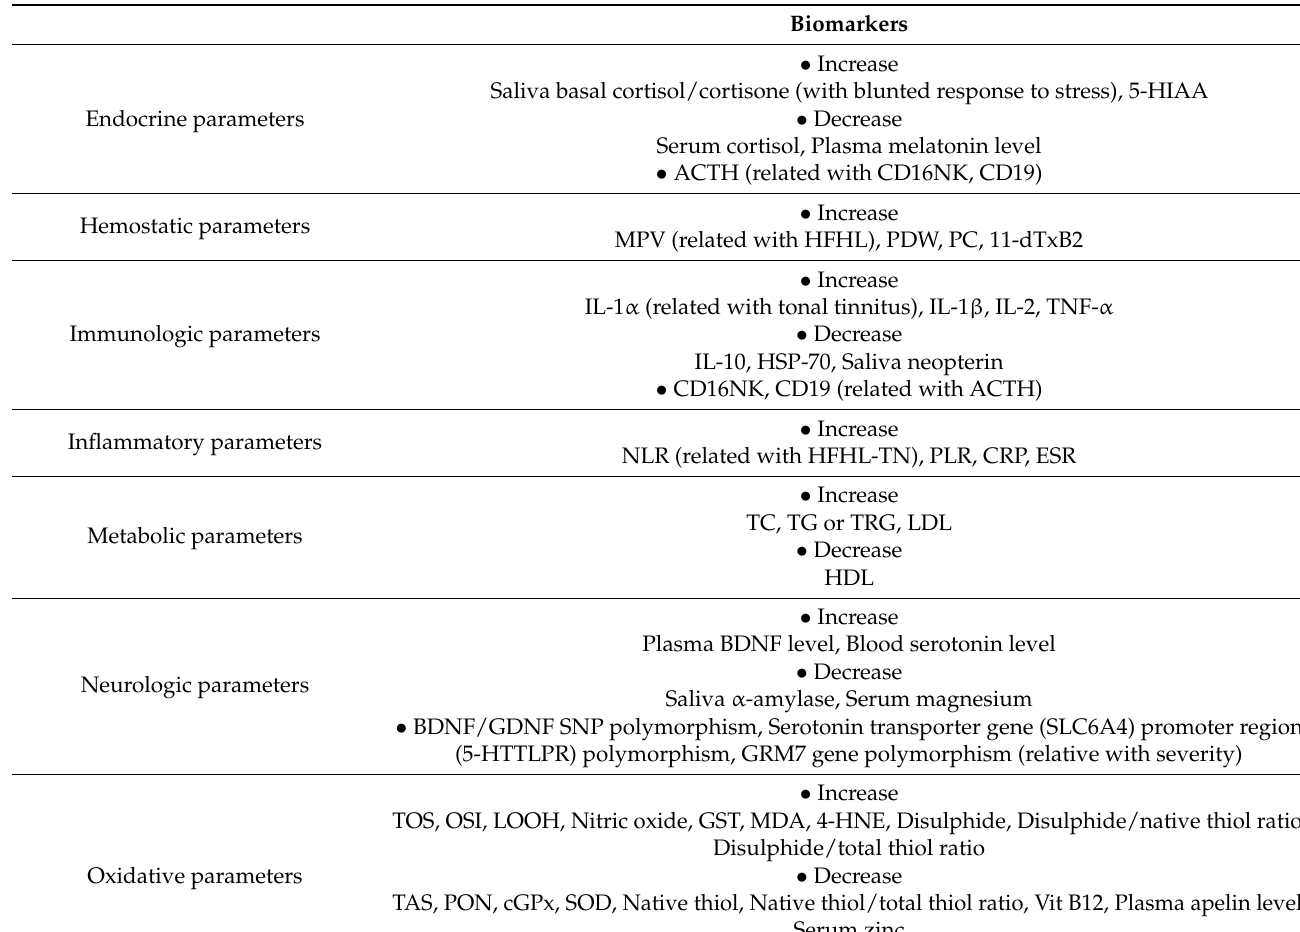
Table 1. Biomarkers suggesting prognosis and severity in chronic subjective